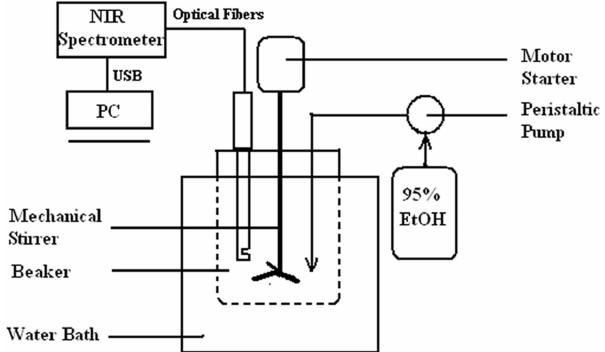
Fig. 1. Schematic of experiment setup for alcohol precipita- tion of